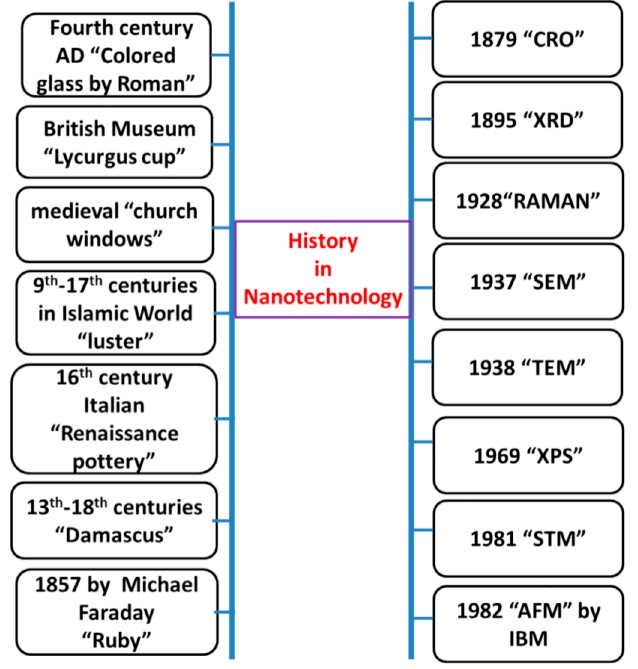
Figure 5. Progresses in Figure 5 . Progresses in Nanotechnology.